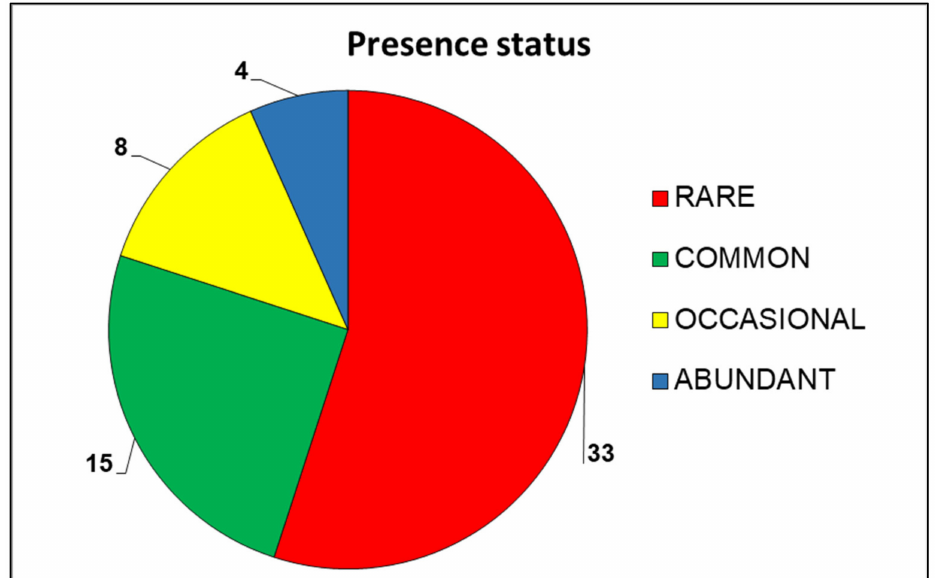
Figure 1. The division of Adriatic chondrichthyans according to their presence.